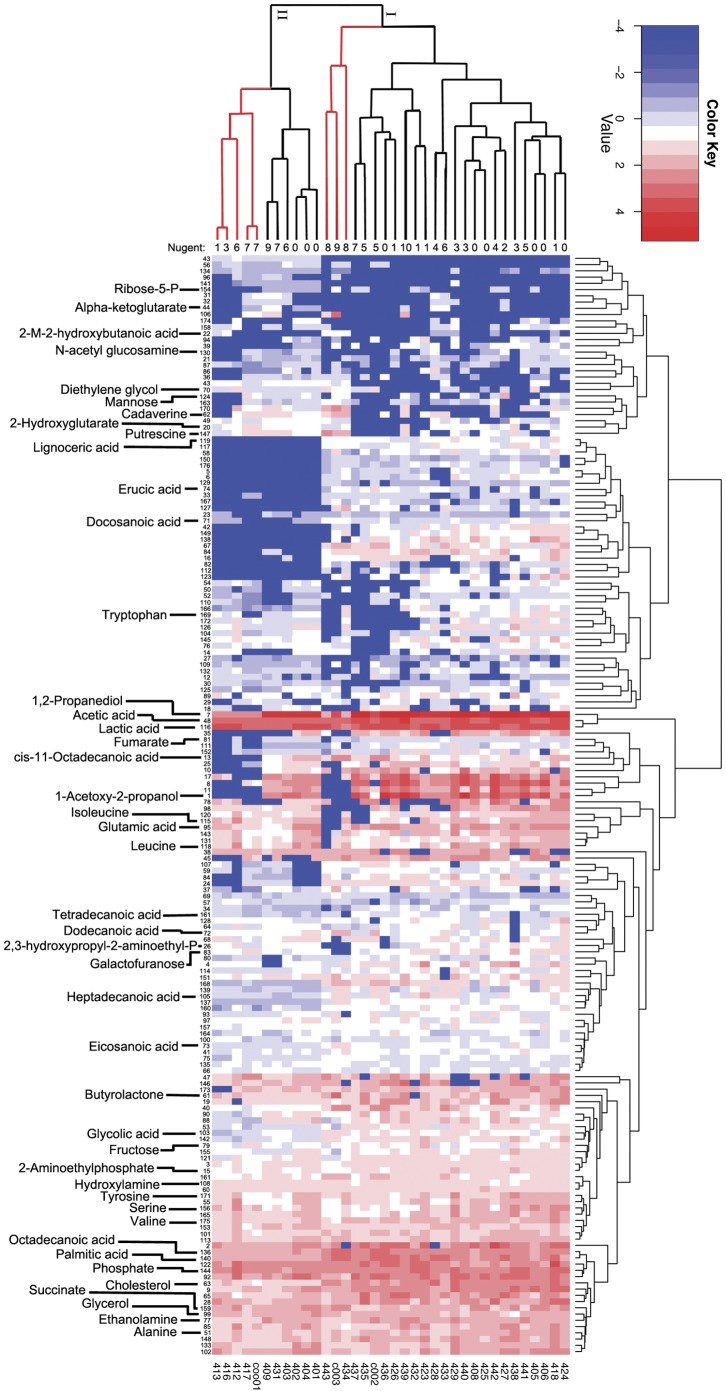
Heatmap of Metabolite Enrichment by Sample.Shown is a heatmap of the relative enrichment of each metabolite across the entire sample set and the relationships among samples and among metabolites. Highly abundant metabolites tend toward red, while less abundant metabolites tend toward blue. Dendrograms show the relationship among samples (top) and among metabolites (left). The two BV metabotypes observed (I and II) are labeled at their branching point. Red bars in the top dendrogram show the relationship of samples with symptomatic BV. Nugent scores are shown for each sample. Metabolite mentioned in-text are labeled, others are numbered as in Table S2.